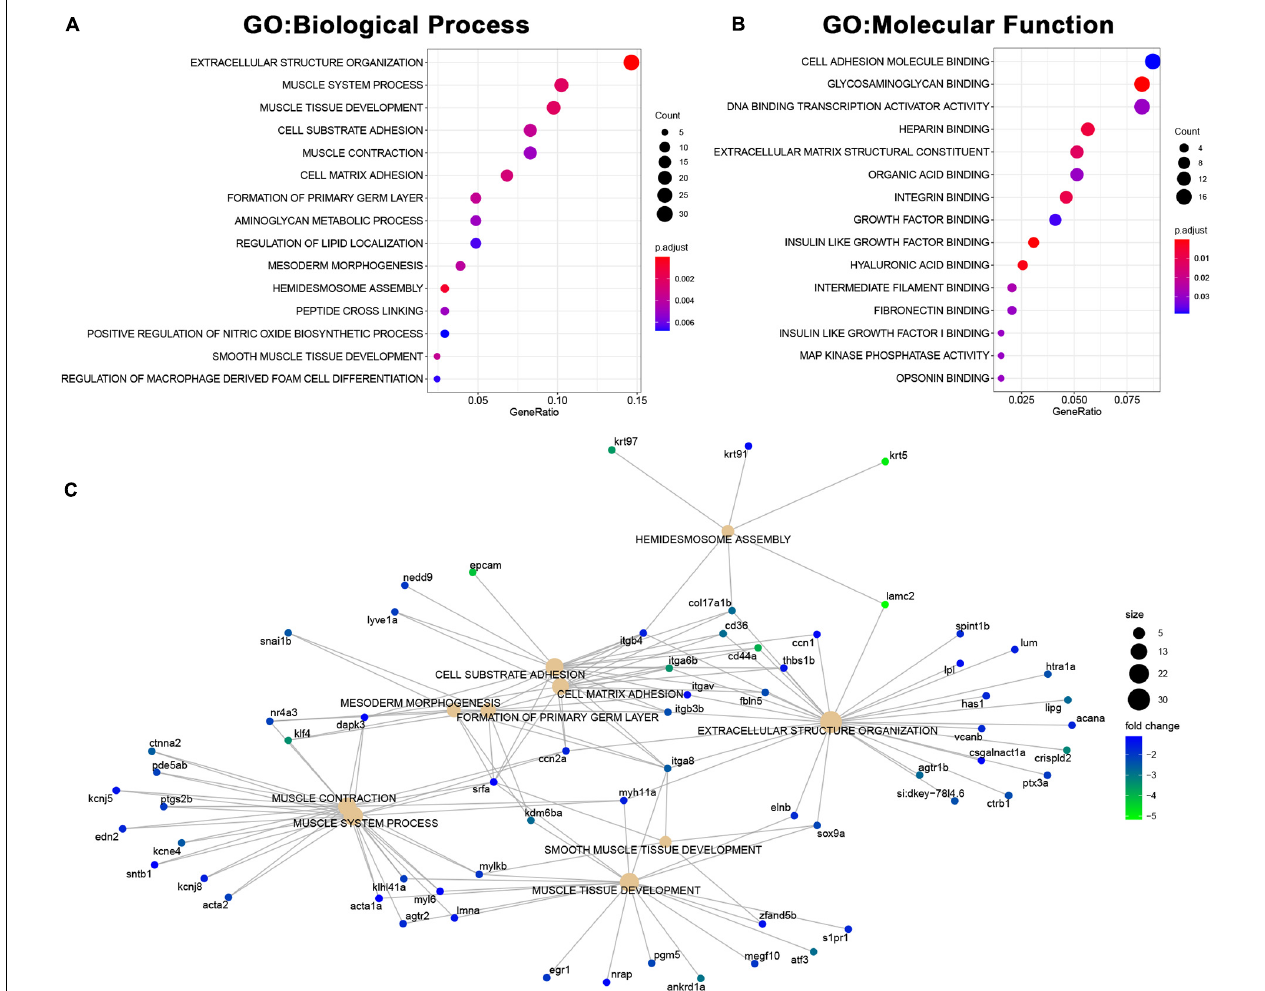
FIGURE 8 | Downregulated genes in MCU hearts suggest defects in cardiac structure and function. (A,B) Dot plots of over-represented Biological Process (A) and Molecular Function (B) gene ontology terms in the set of genes that is significantly downregulated in MCU mutant hearts. The dot size indicates the number of genes associated with each term and the dot color indicates the significance of the enrichment (adjusted p -values). (C) Gene concept networks of the top 10 over-represented Biological Process gene ontology terms in the set of genes that is significantly downregulated in MCU mutants. The dot size indicates the number of genes associated with each term and dots representing genes are colored based on their fold-change